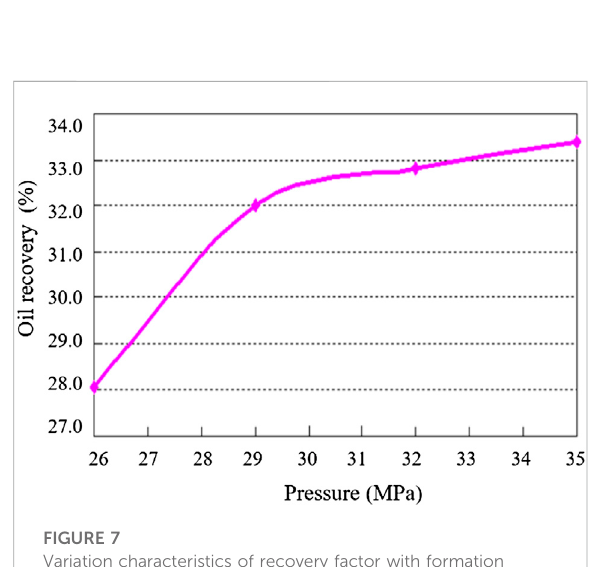
FIGURE 7 Variation characteristics of recovery factor with formation